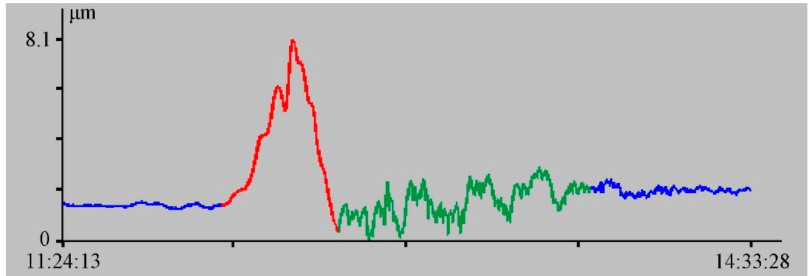
Figure 6. Fragment of “north–south” laser strainmeter record for 15 January 2022, UTC.